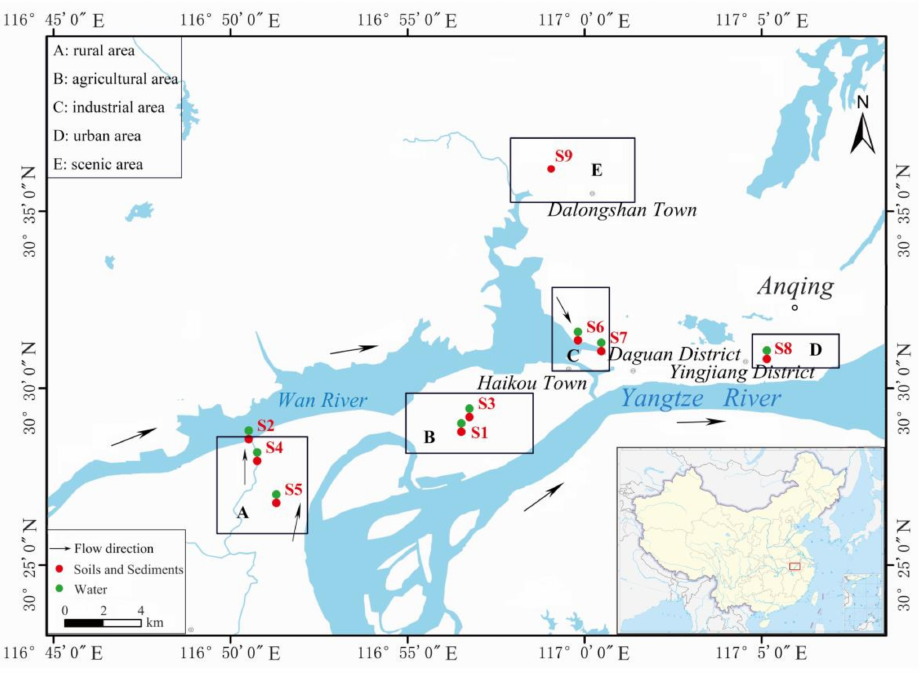
Figure 1. Cartographic illustration of the sampling sites in Anqing